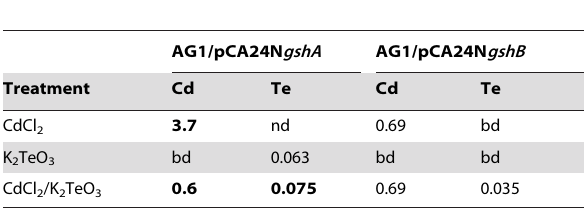
Figure 2. Fluorescence assessment in E. coli overexpressing gshA or gshB genes. UV light-exposed cell pellets of E. coli AG1/ pCA24N gshA (A) or AG1/pCA24N gshB (B) that were untreated (1) or exposed to CdCl 2 (2), K 2 TeO 3 (3) or CdCl 2 /K 2 TeO 3 (4).